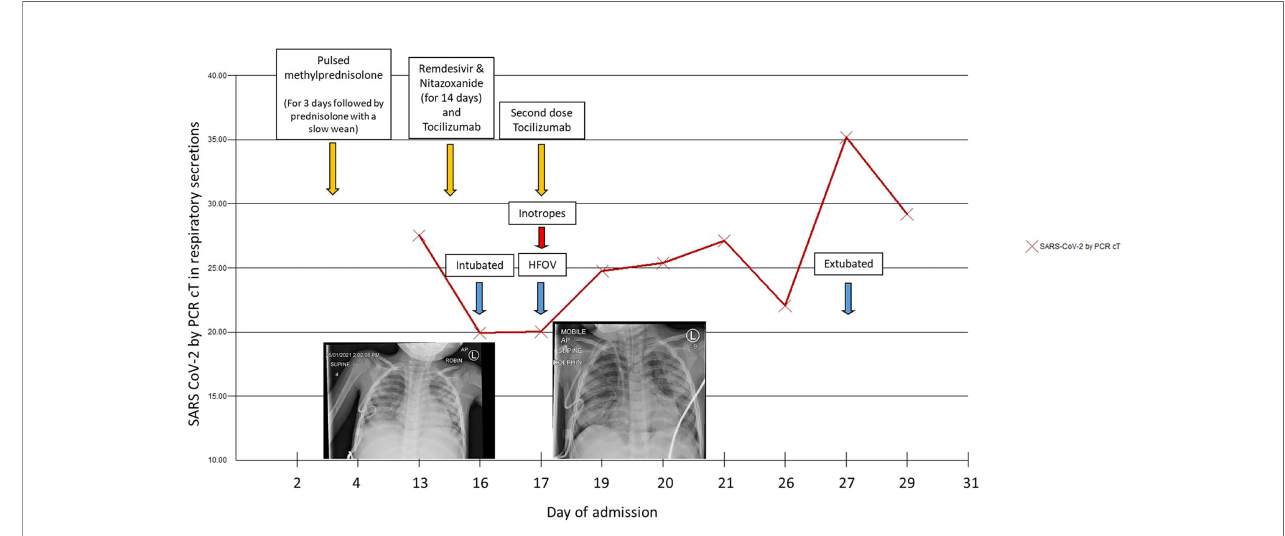
FIGURE 1 | SARS CoV-2 cycle threshold (cT) over time and chest X-rays from Day 13 (left) showing widespread patchy airspace opaci fi cation and Day 16 (right) post- intubation showing a large volume pneumomediastinum, with “ continuous diaphragm ” sign and gas extending superiorly into the neck and inferiorly below the